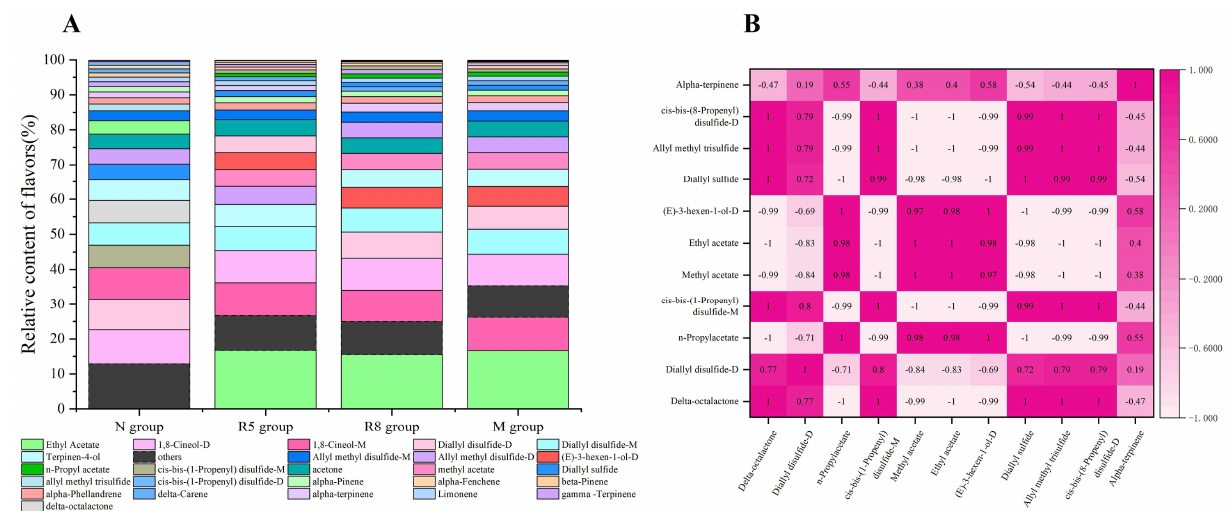
Figure 6. The relative content of flavors in pickles. ( A ) Correlation matrix of Pearson’s rank correlation among the major component. ( B ) Pearson’s rank correlation coefficient ranges from 1.0 to −1.0, corresponding from strongly positive to strongly negative correlation. Only content with an abundance >0.1% in at least one sample is shown in ( A ).